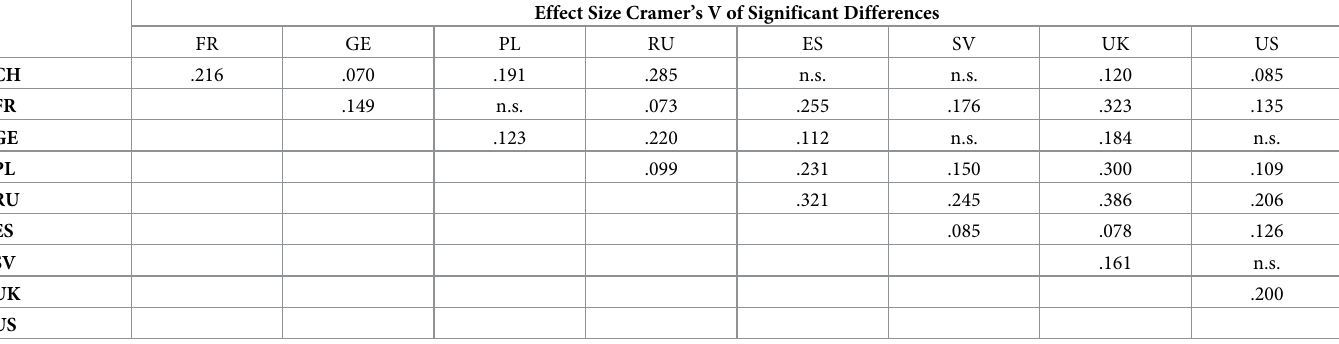
Table 3. Simplified presentation of the effect sizes (Cramer’s V) of the comparison of Covid-19 vaccination willingness between the countries via Pearson Chi- Square test. Effect Size Cramer’s V of Significant